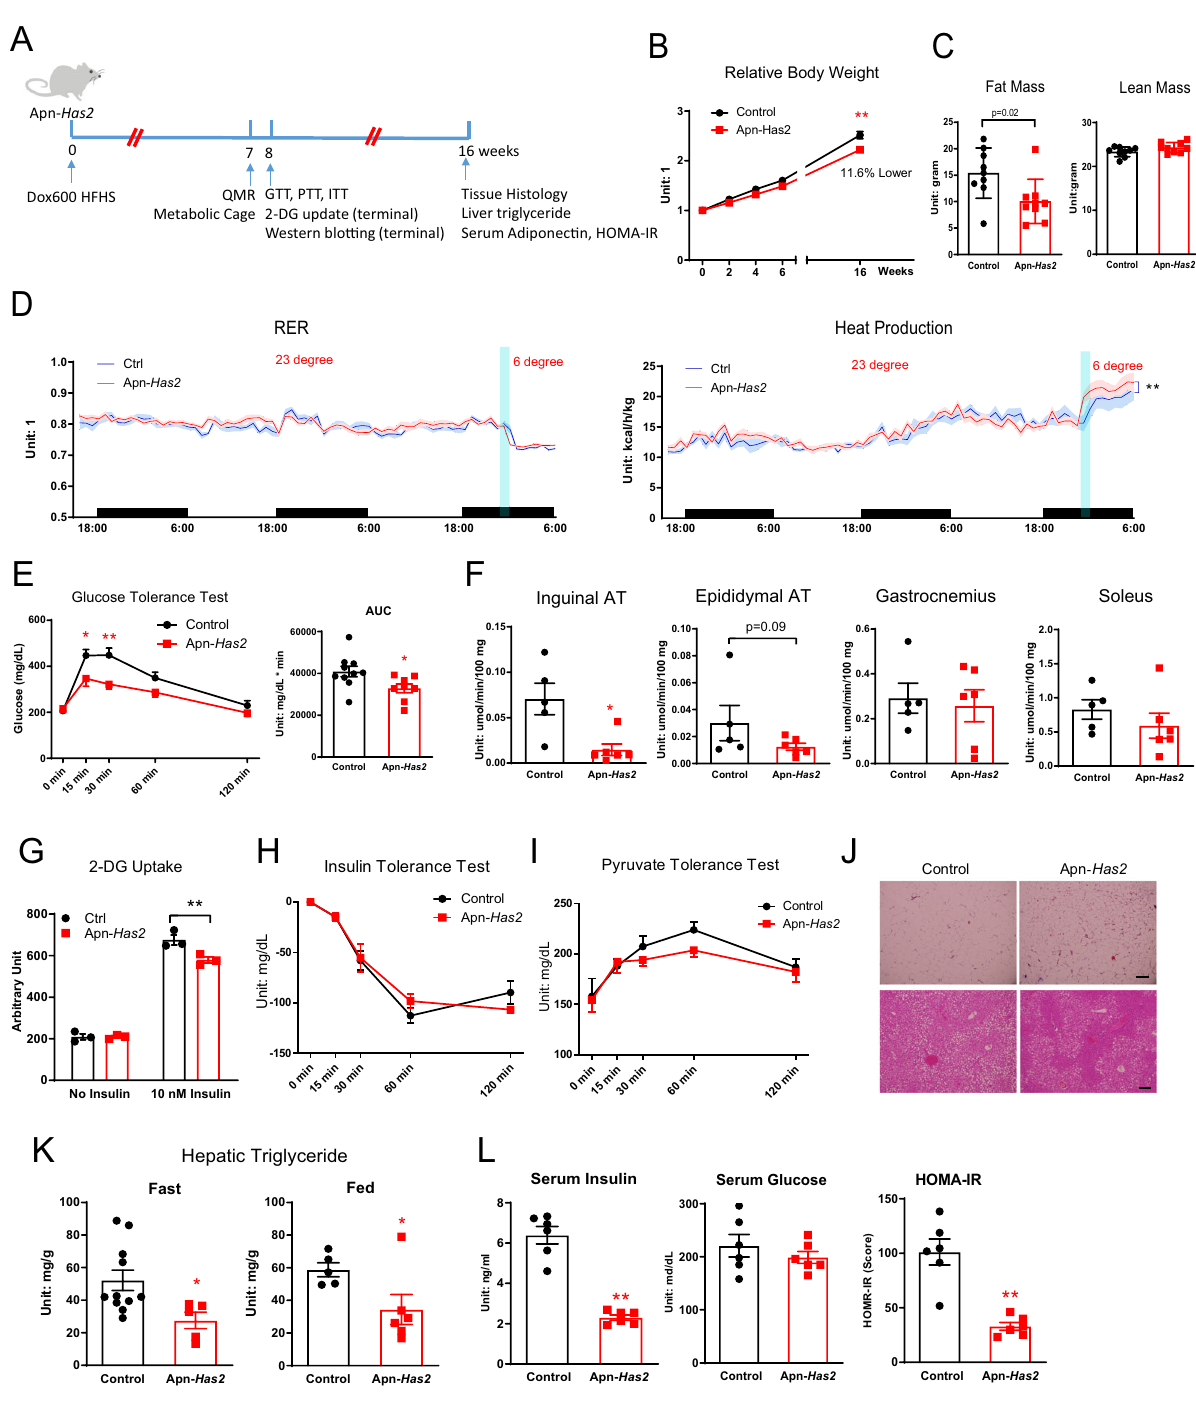
(Fig. 5G). Pyruvate tolerance tests did not differ between the HA treatment group and the PBS control group (Fig. 5H). The insulin tolerance test revealed a mild impairment in peripheral insulin sensitivity (Fig. 5I). Altogether this re fl ects a marginal effect of systemic HA treatment on glucose homeostasis and can ’ t account for metabolic improvement seen in Apn- Has2 mice. Increasing circulating HA by hepatic Has2 overexpression does not improve glucose tolerance . Injection of HA may cause a signi fi cant fl uctuation in circulating HA not seen in mice, so we used another mouse model — a liver-speci fi c, doxycycline- NATURE COMMUNICATIONS| (2021) 12:4829